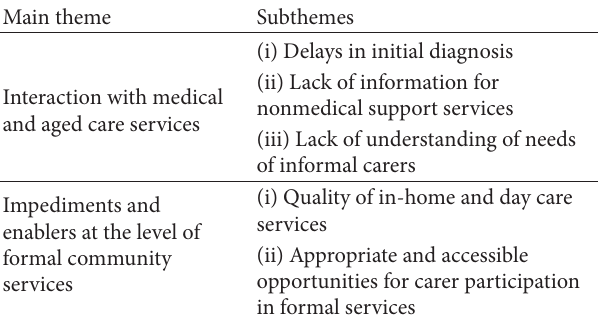
Table 1: Main themes and subthemes based on carers perspectives of intersection of formal and informal dementia care